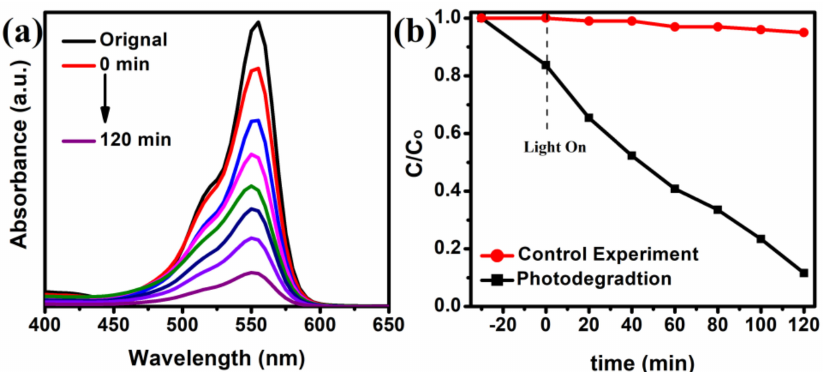
Figure 7. Time-dependent absorption spectra of RhB solution in visible light ( a ), and the degradation of RB in visible light ( b ).